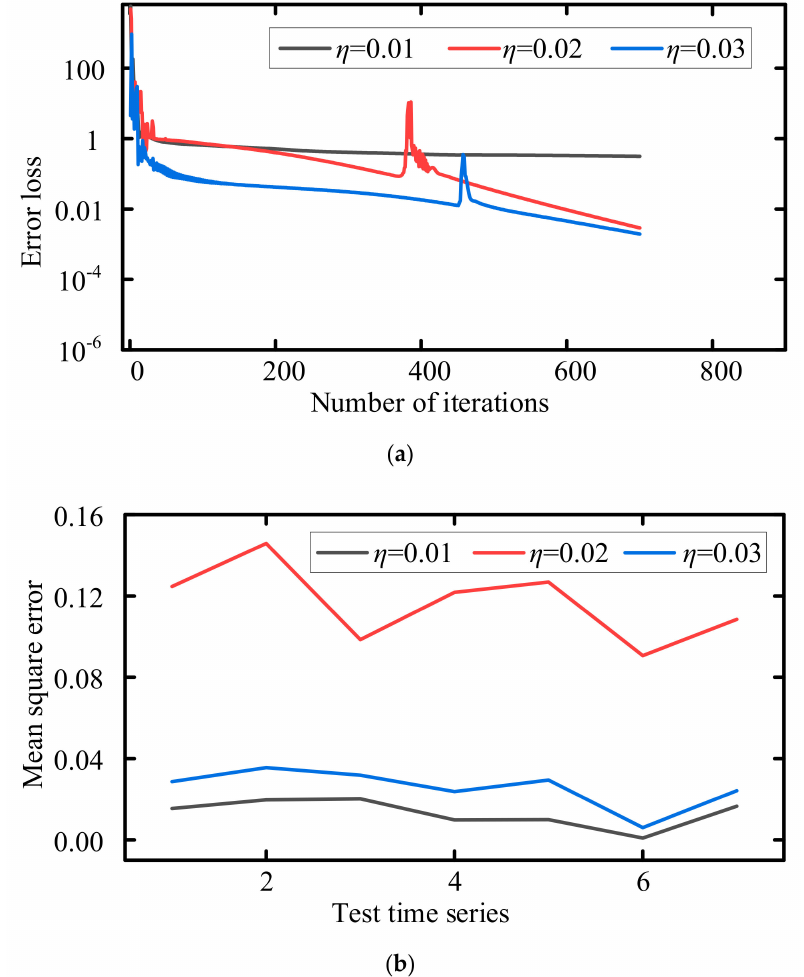
Figure 8. Variation of error loss and mean square error comparison of LSTM models at different learning rates. ( a ) Error loss of LSTM models at different learning rates. ( b ) Mean square error of LSTM models at different learning